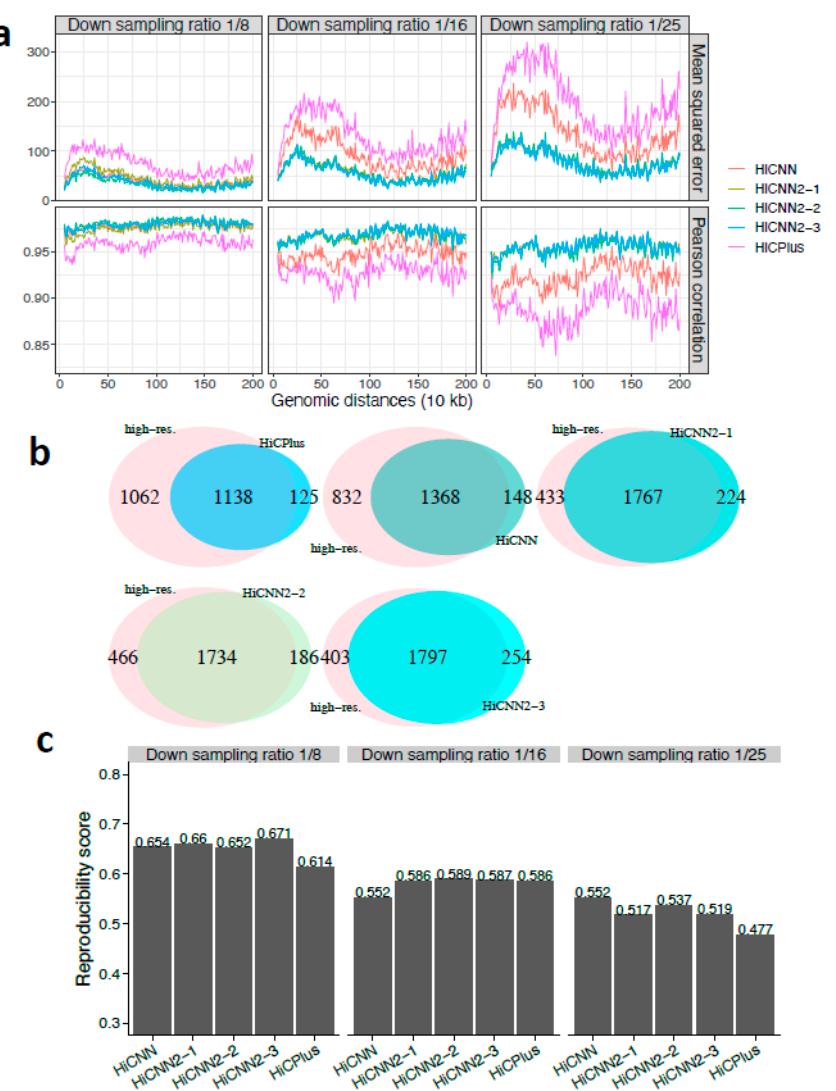
Figure 5. The evaluation results on the bacterial C. crescentus chromosome between experimental high-resolution Hi-C (10 kb resolution) and each of the five predicted Hi-C data sets, namely, HiCPlus-enhanced, HiCNN-enhanced, HiCNN2-1-enhanced, HiCNN2-2-enhanced, and HiCNN2-3-enhanced: ( a ) mean squared error and Pearson’s correlations with three di ff erent down-sampling ratios (1 / 8, 1 / 16, and 1 / 25); ( b ) the e ff ectiveness of recovering significant interactions (detected by Fit-Hi-C with q -value < 0.05) with a down-sampling ratio of 1 / 25; and ( c ) the reproducibility scores with the three down-sampling ratios.